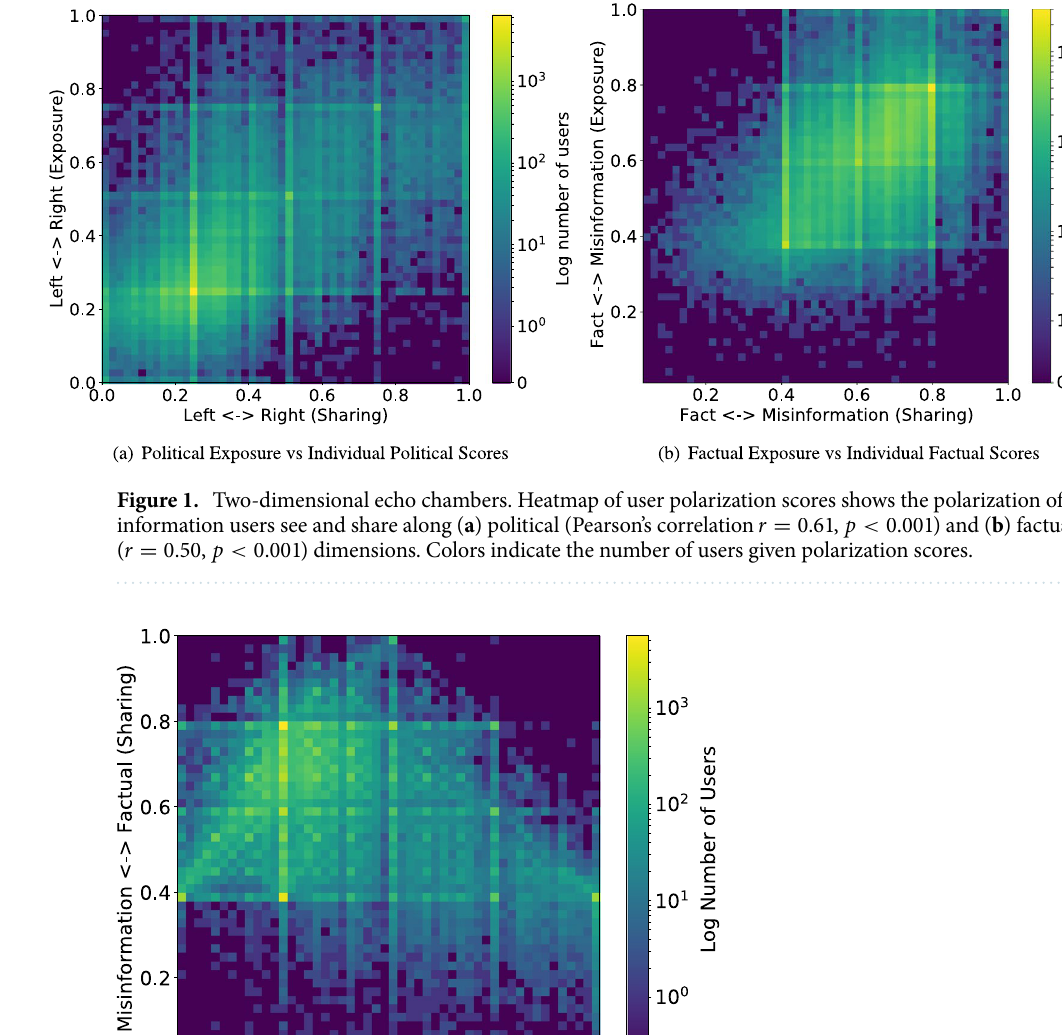
topics (“pandemic”, “wearamask”, “stayhome”), people sharing misinformation are preoccupied with politics (“trump2020”, “kag2020”, “democrats”, “maga”) and conspiracies (“plandemic”, “qanon”, “wwg1wga”). Interest- ingly, these users also mention media to a much greater extent, using topics like “foxnews”, “7news”, “foxand- friends”, “morningjoe”, and “fakenews”. This may suggest the greater role that media plays in agenda-setting for people vulnerable to misinformation. Also, unlike factual users, people spreading misinformation also discuss unproven cures, like “hydroxychloroquine”. Partisan asymmetries in exposure to misinformation. How does the interaction between partisan- ship and factuality affect what information users are exposed to and, in turn, what information they share? Do people effectively filter out misinformation they see by selectively sharing more factual content? Figure 3 visualizes user exposure to polarized information. The top row shows user exposure to political and factual information as a function of user political (Fig. 3a) and factual (Fig. 3b) scores. Note that while Fig. 3a,b represents users in the same space as in Fig. 1a,b, i.e., a user’s political/factual scores vs the scores of their political/ factual exposures, the colors in the latter show density while the colors in the former show their factual and politi- cal opinions respectively. There are several regions of interest in Fig. 3a. Liberal users ( p l < 0.5 ) who are exposed to politically moderate content ( p e ≈ 0.5 ) see the most factual information (dark orange). Liberals ( p l < 0.5 ) who are exposed to liberal content ( p e < 0.5 ) generally see more factual (orange) information, although as their exposure becomes more partisan, the share of factual content they see dwindles. Those exposed to extreme left